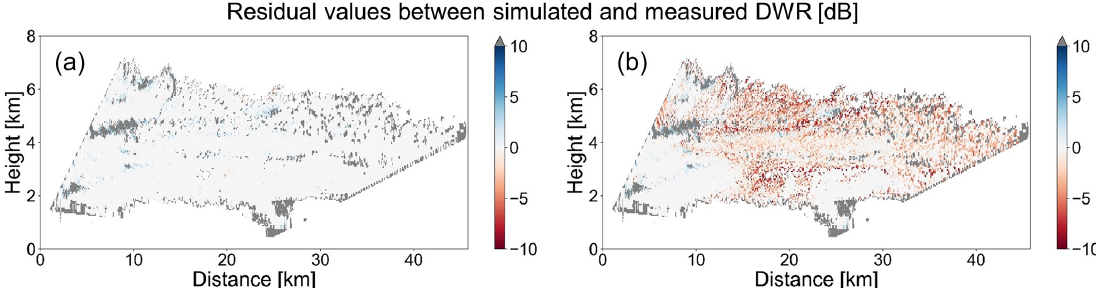
Figure 16. Difference (residuals) between simulated and measured values of DWR for ice spheroids that follow m(D max ) of (a) aggregates and (b) BF95 for 30 January 2019 at 10:08UTC. For better visualization purposes the − 5, − 15, and − 25 ◦ C temperature lines are not plotted here. Areas where ice-masked and noise-filtered measurement values are located are plotted with